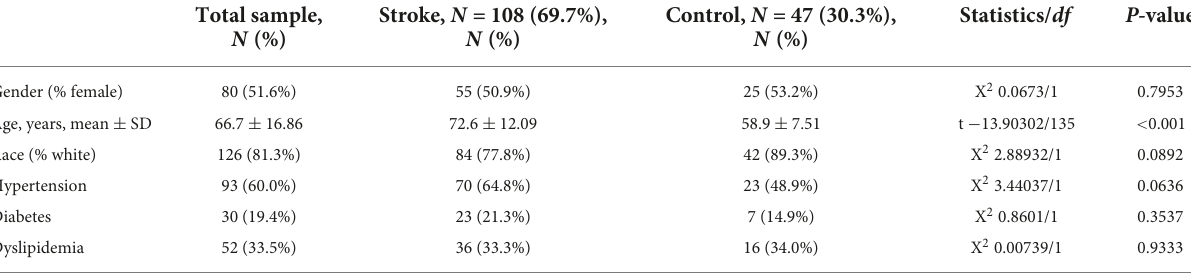
TABLE 2 Clinical characters of the merged IS training data sets.